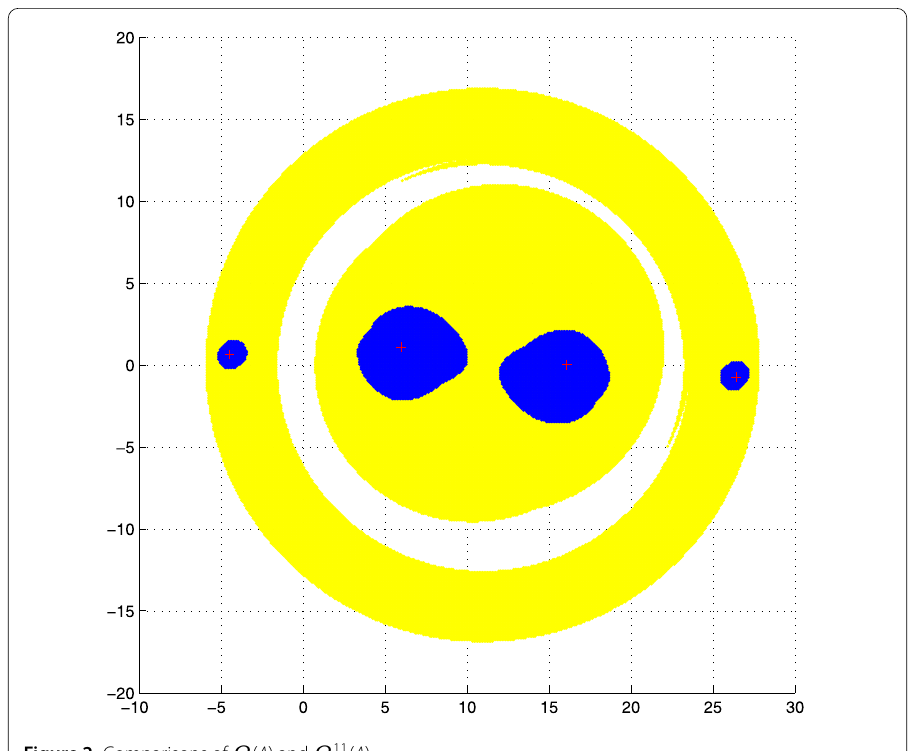
Figure 2 Comparisons of Ω ( A ) and Ω 11 2 ( A